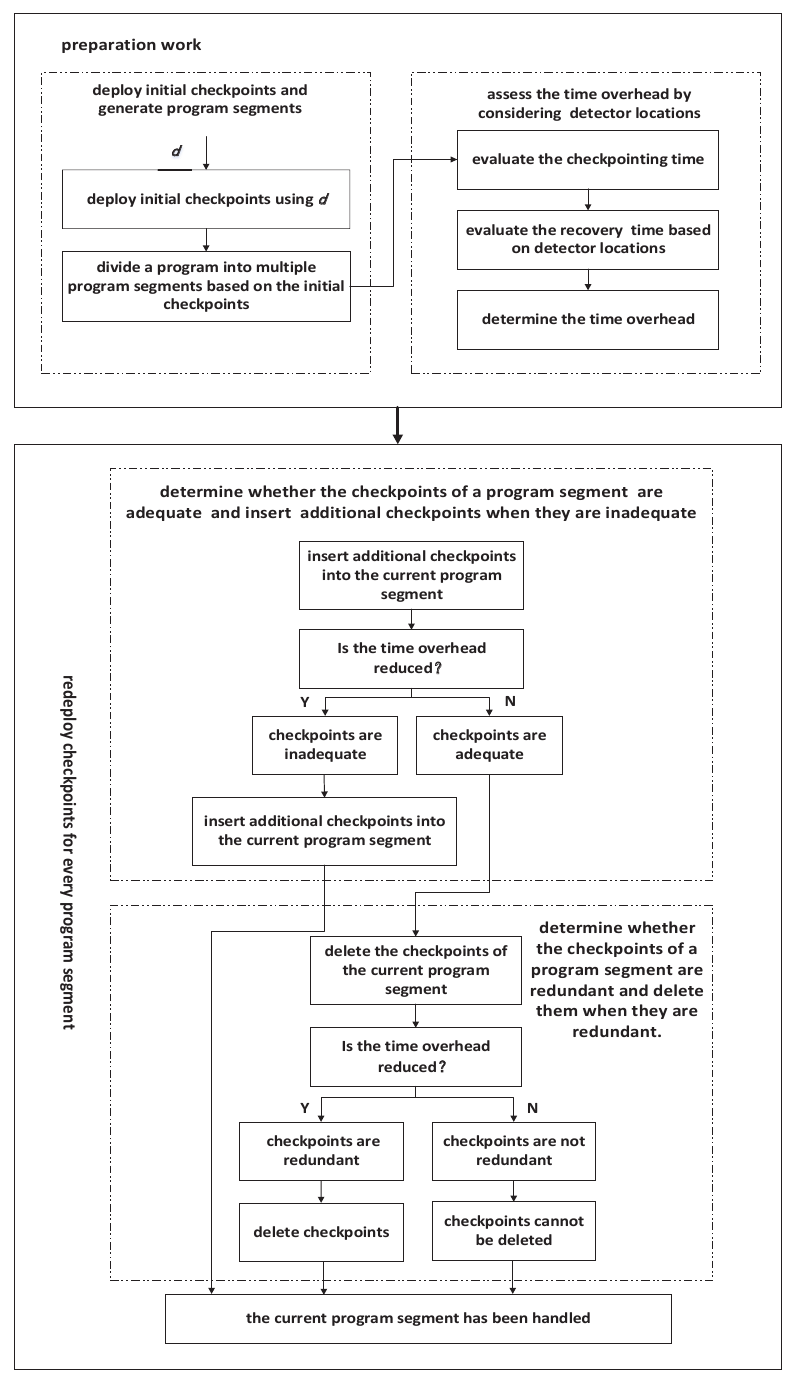
Figure 6. The overview of the DLCKPT